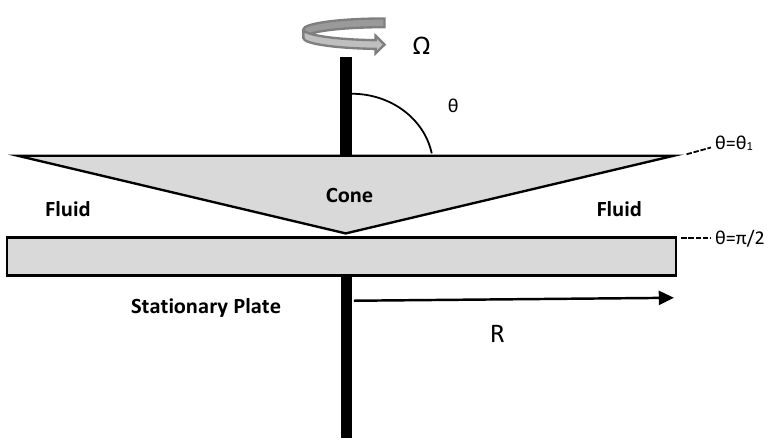
Figure 1. Schematic diagram of a cone-and-plate viscometer.